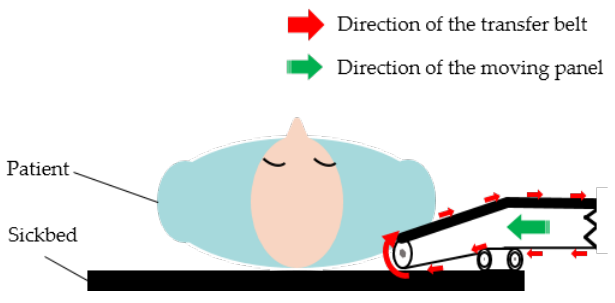
Figure 2. Clinical transformation of patient transfer